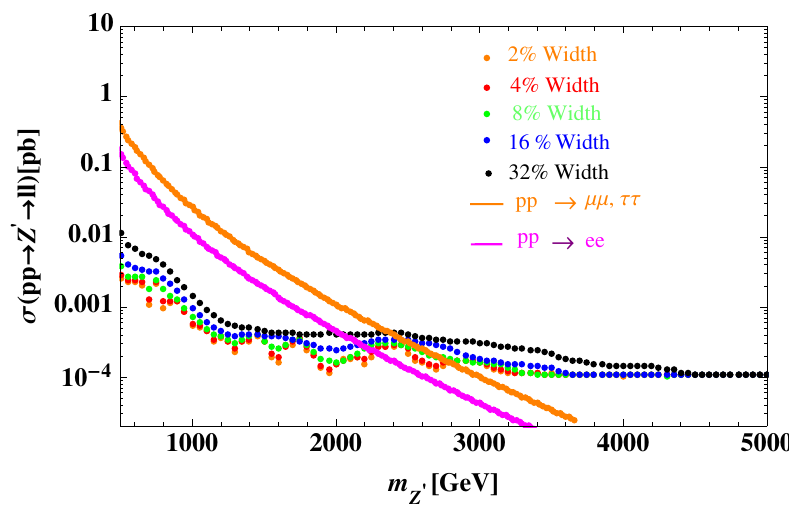
Figure 7 . Dilepton production cross-section as a function of the new neutral gauge boson mass. The dotted lines are observed limits for di(cid:11)erent widths extracted at the resonance mass of dilepton, p using 36.1 fb (cid:0) 1 of pp collision at s = 13 TeV by the ATLAS experiment